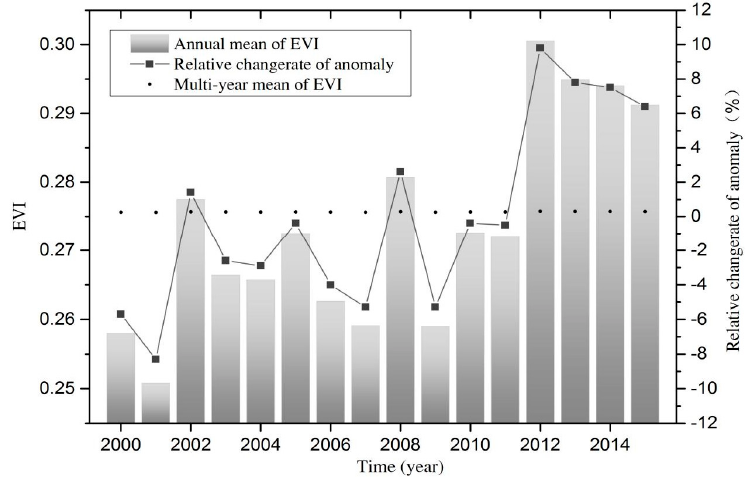
Figure 3. Inter-annual change of EVI in the study area from 2000 to 2015.